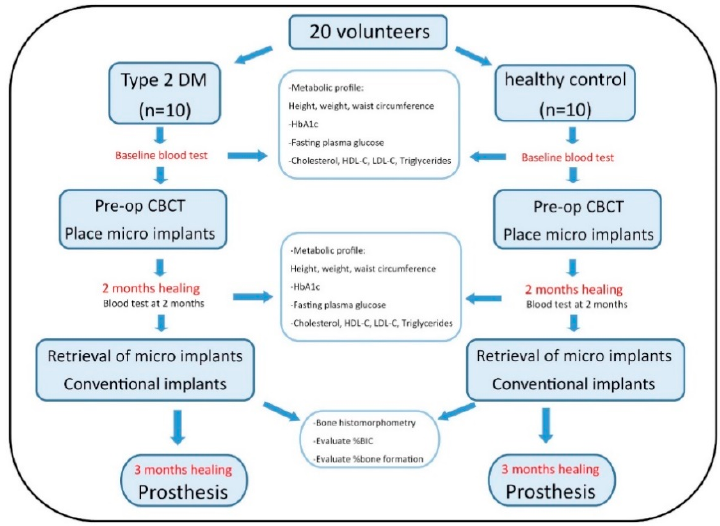
Figure 2. Summary of research protocol.